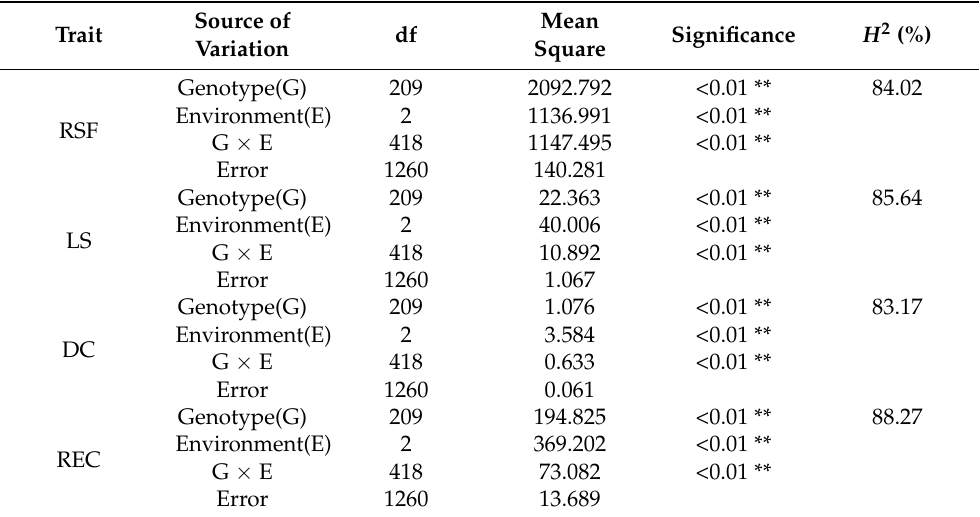
Analysis of variance (ANOVA) and broad-sense heritability ( H 2 ) for four traits under three